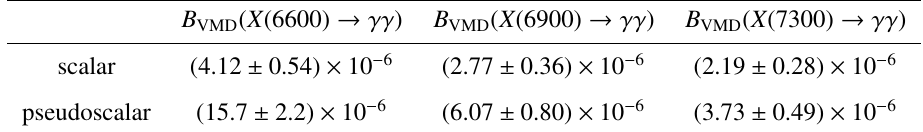
Table 2. Our VMD estimate of two-photon branching ratios for resonances detected at CMS[5]. B VMD ( X (6600) → γγ ) B VMD ( X (6900) → γγ ) B VMD ( X (7300) → γγ ) scalar